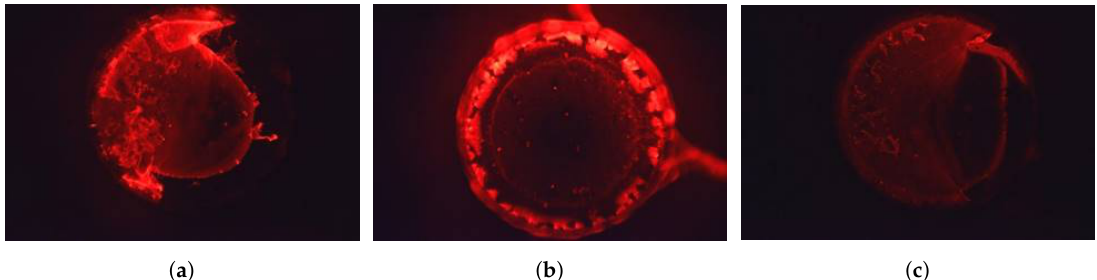
Figure 3. Fluorescence imaging from static hybridization tests. ( a ) Capture probe + extender molecule + fluorescence tag. ( b ) Off-chip RNA + fluorescence tag (no washed). ( c ) Capture probe + extender molecule + off-chip RNA + fluorescence tag (after washing).